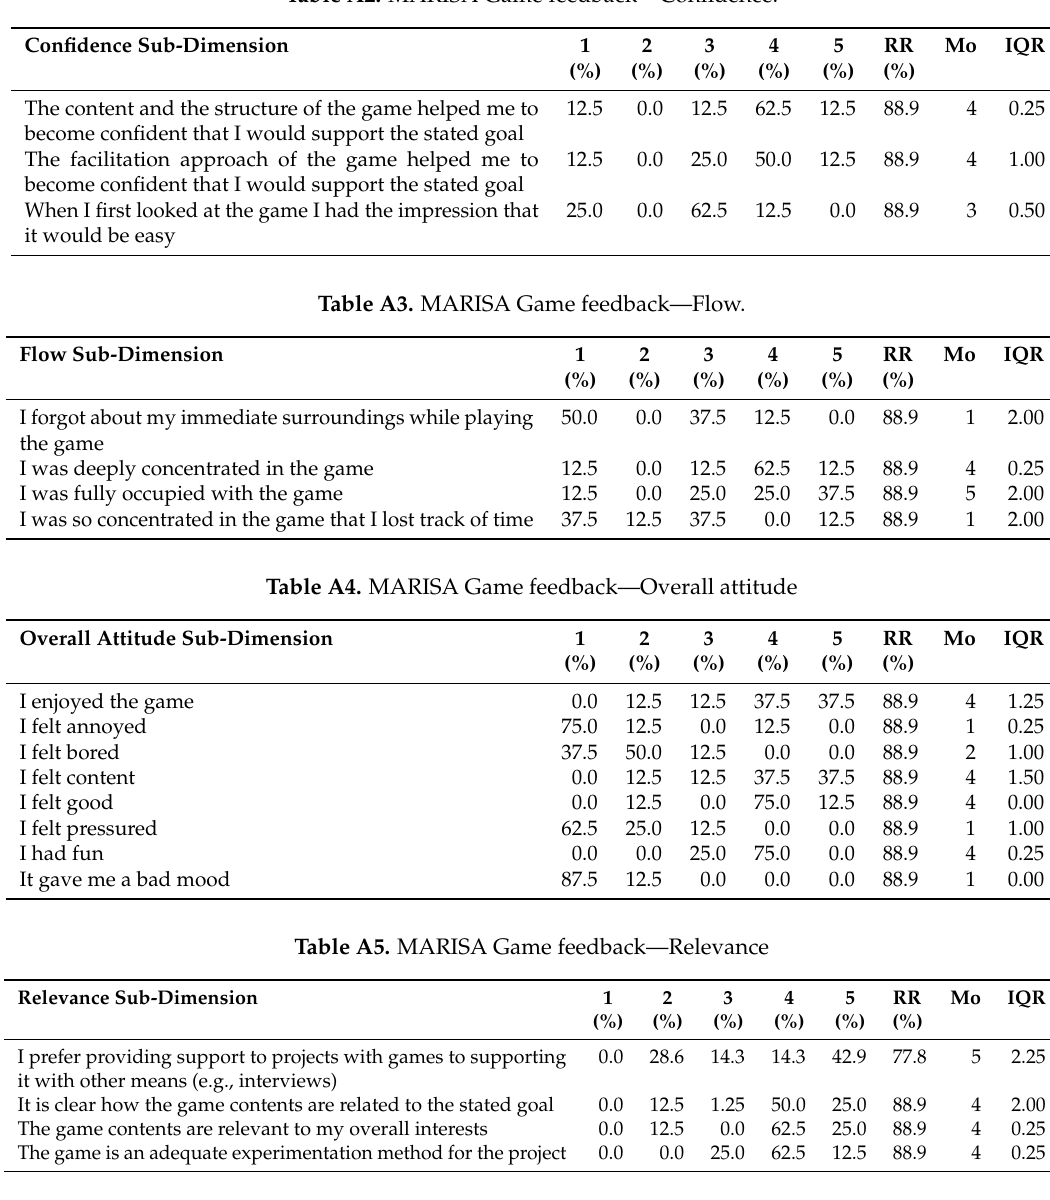
Table A2. MARISA Game feedback—Confidence.